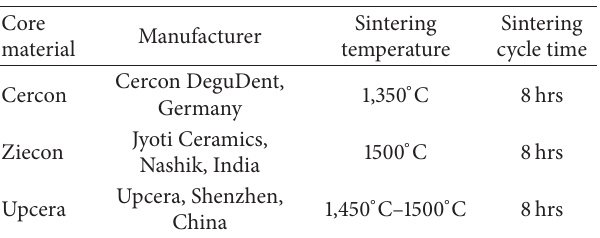
Table 3: Properties of veneering material as provided by the